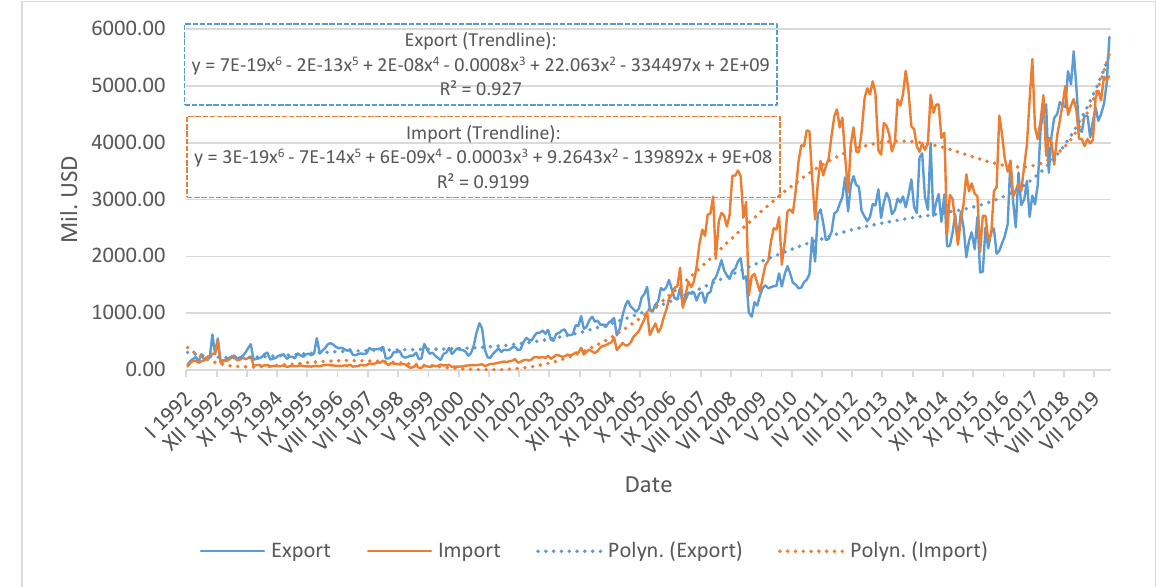
Figure 7. Export and import with significant impact of sanctions on development of trade relations (Source: Author).